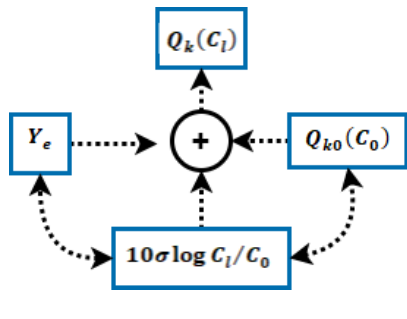
Figure 6. Path loss.